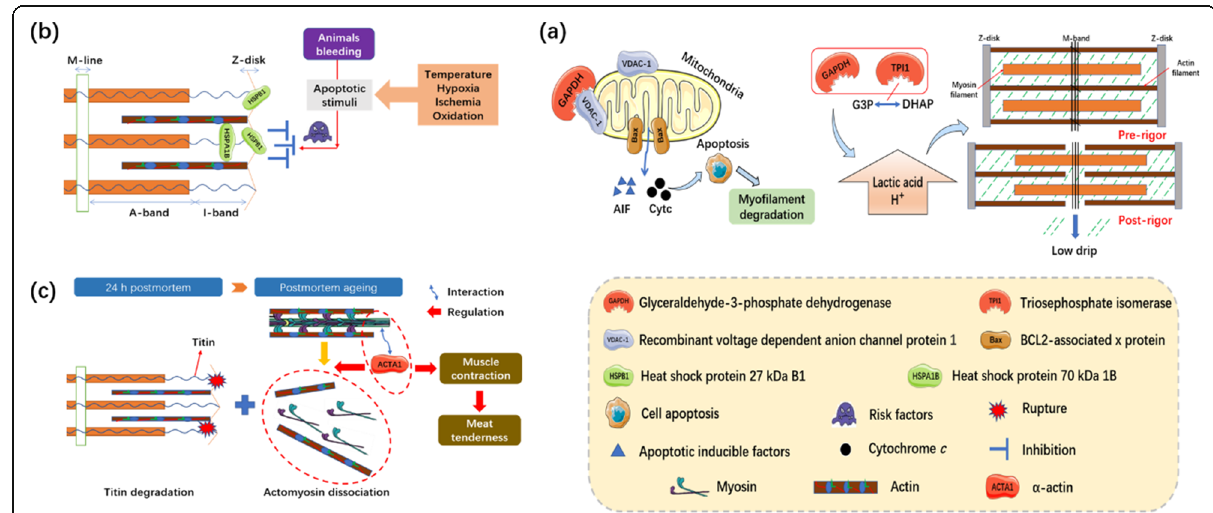
Fig. 4 The main identified biomarkers related to meat tenderness and biological pathways of metabolic enzymes ( a ), heat shock proteins ( b ) and structural proteins ( c